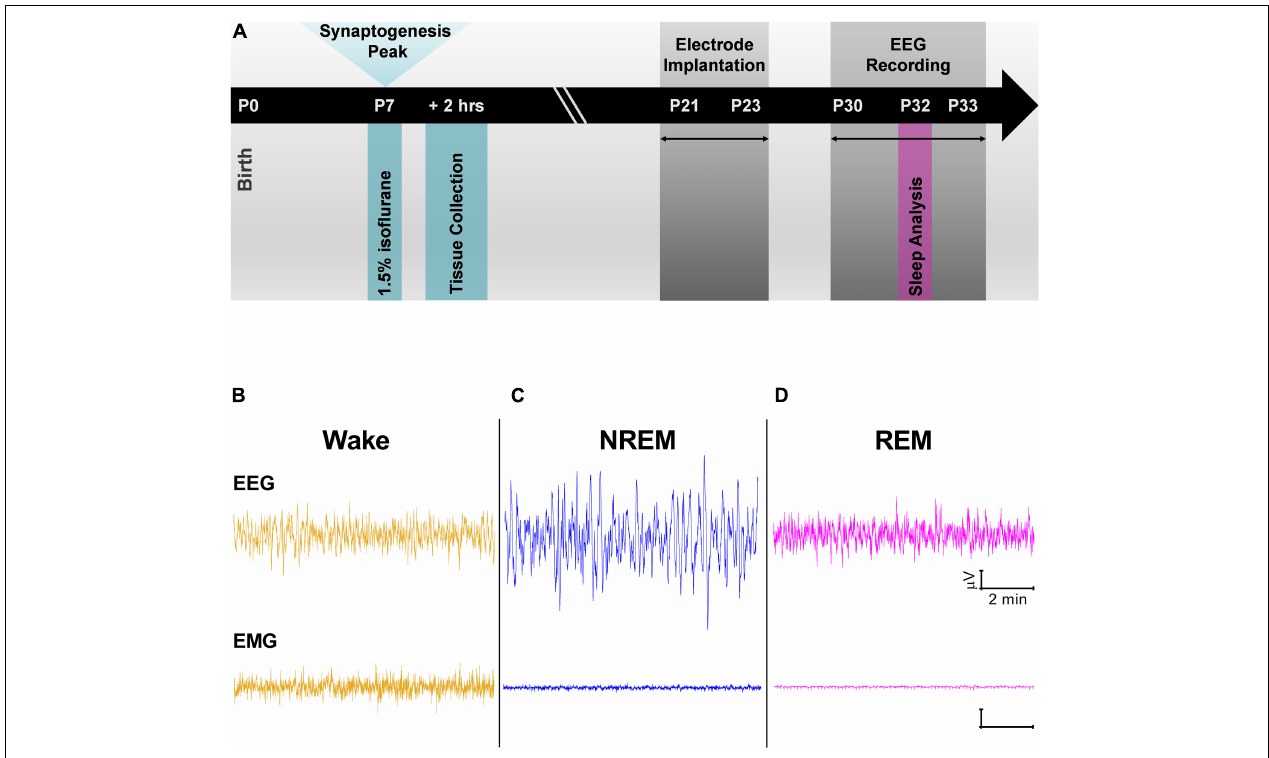
FIGURE 1 | (A) Schematic representation of experimental timeline. Exposure to 1.5% Isoflurane for 6 h occurred at P7 during peak synaptogenesis. One cohort of animals was used to quantify neuroapoptosis 2 h after anesthesia exposure. A second cohort of animals was raised with their mothers until weaning age before being implanted with electroencephalogram (EEG) electrodes. Adolescent rats were given at least a week to recover from surgeries, and at P30 EEG recordings began. Data from P32 and P33 were used in all analyses. (B–D) Cortical EEG and electromyography (EMG) representative traces were used alongside time-locked videos to score sleep. (B) Traces during wake have mixed frequency/low amplitude EEG and represent an animal that was freely and actively moving as noted by its high frequency EMG. (C) Representative traces during non-rapid eye movement (NREM) show low frequency cortical oscillations and minimal movement in EMG. (D) Cortical oscillations during rapid-eye movement sleep (REM) are similar to those of Wake stage but with flat line in the